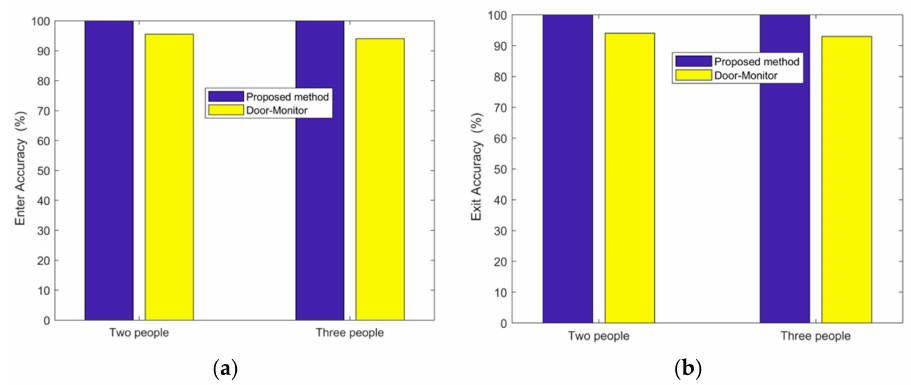
Figure 11. Accuracy of passing direction detection at a large empty laboratory. ( a ) Enter. ( b ) Exit.